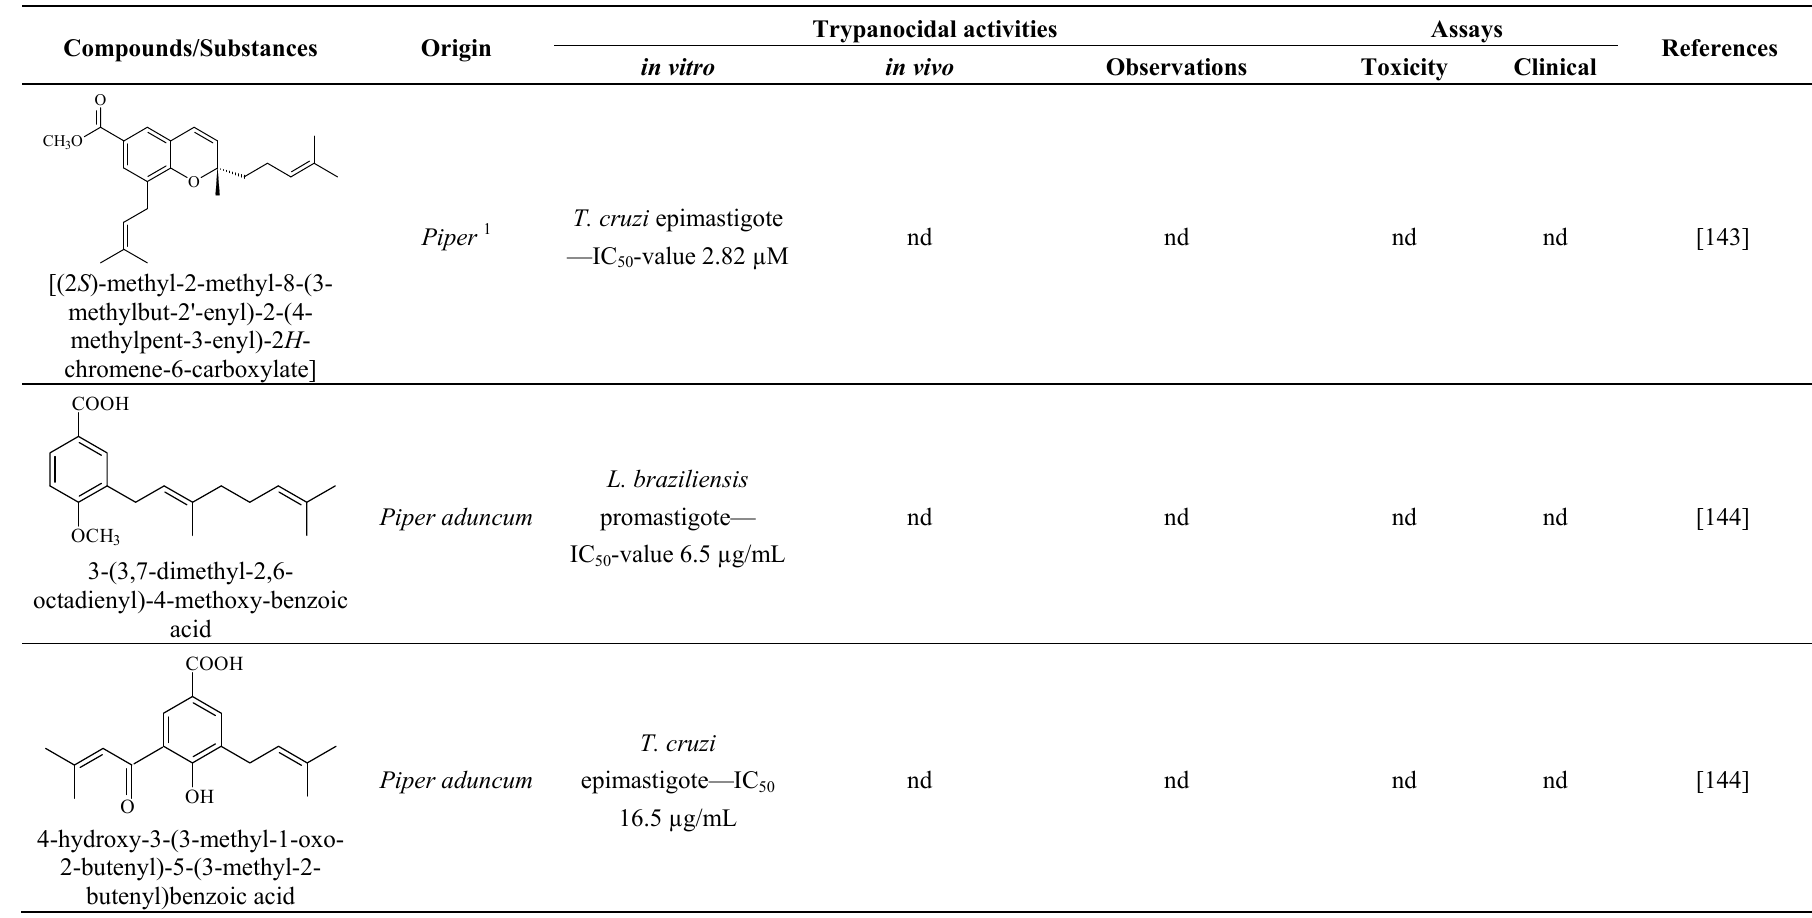
Table 3. List of medicinal plants, products and active compounds known to have anti-trypanosomal